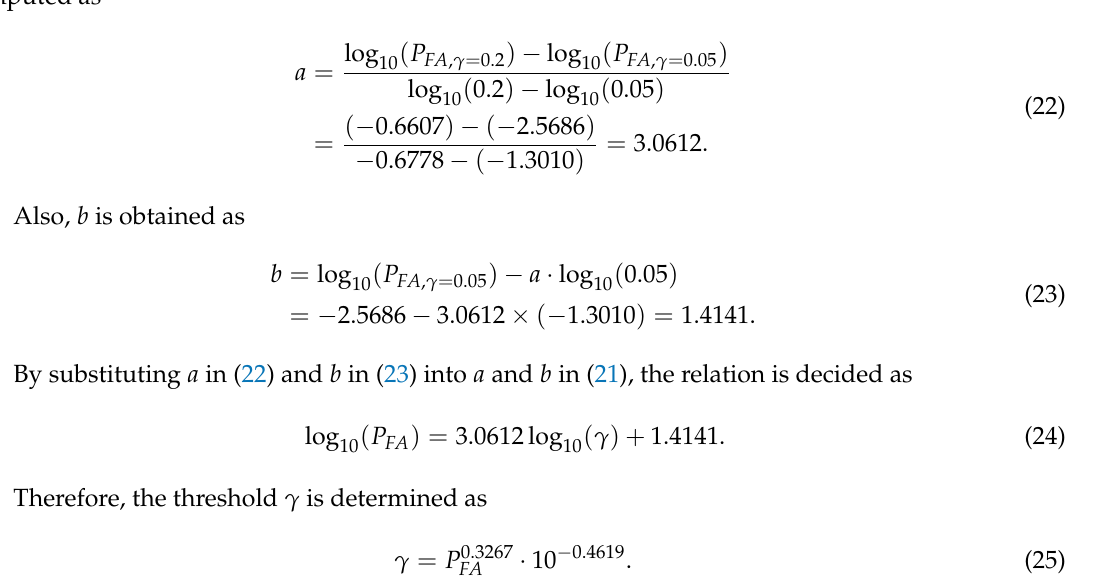
Table 1. Two pairs of ( log